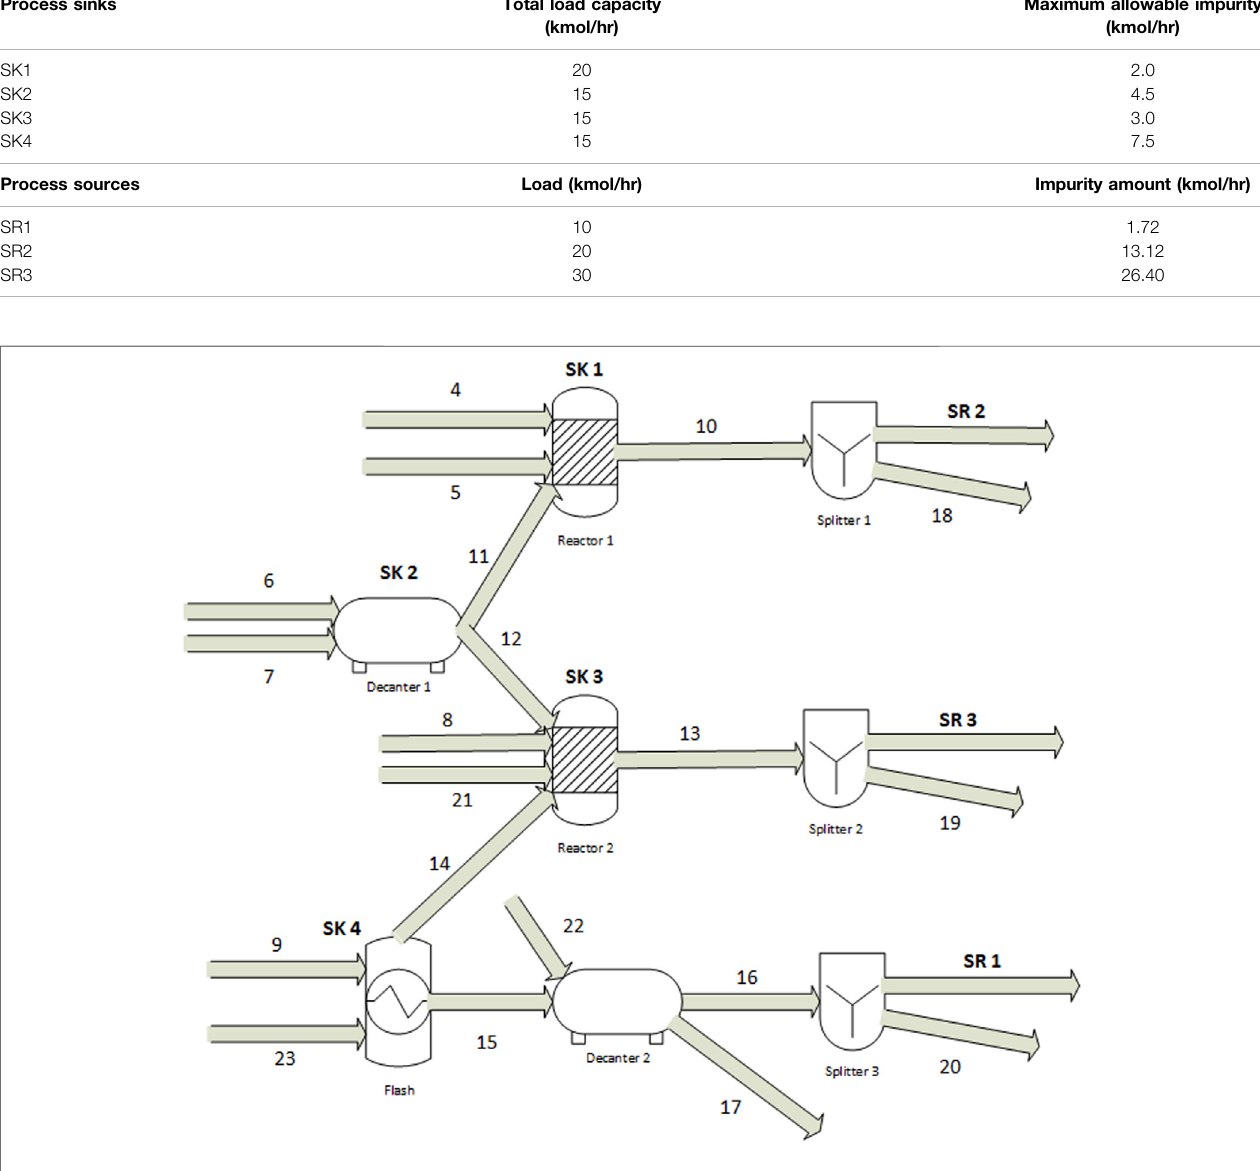
Frontiers in Chemical Engineering |